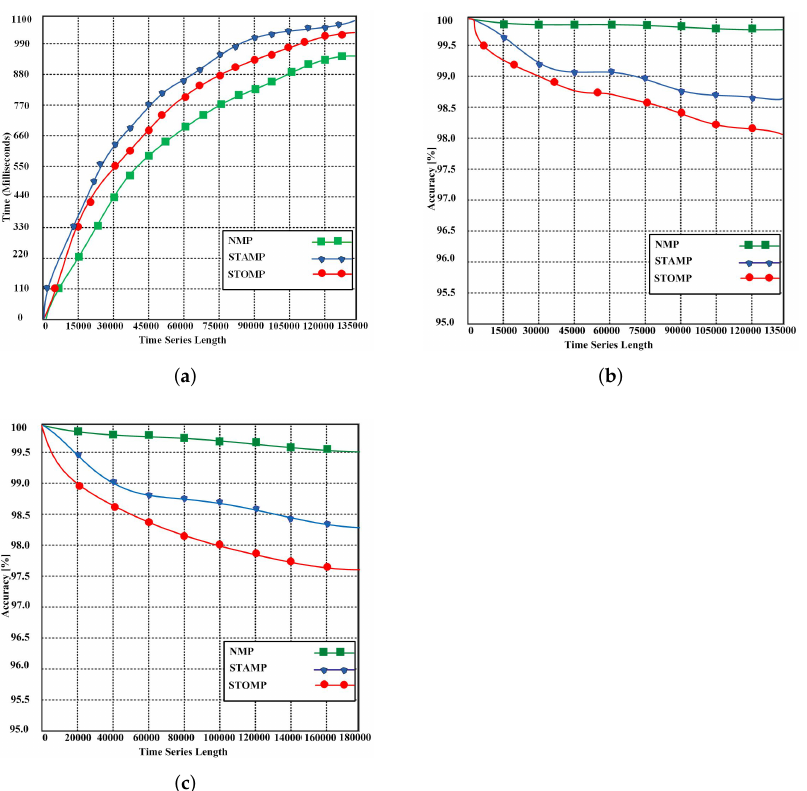
Figure 5. ( a ) Run-time execution in seconds for NMP, STAMP, and STOMP with n = 135,000, varying the time series length. ( b ) Accuracy of NMP, STAMP, and STOMP with a maximum of 135,000 for the time series data length. ( c ) Accuracy of NMP, STAMP, and STOMP with a maximum of 180,000 for the time series data